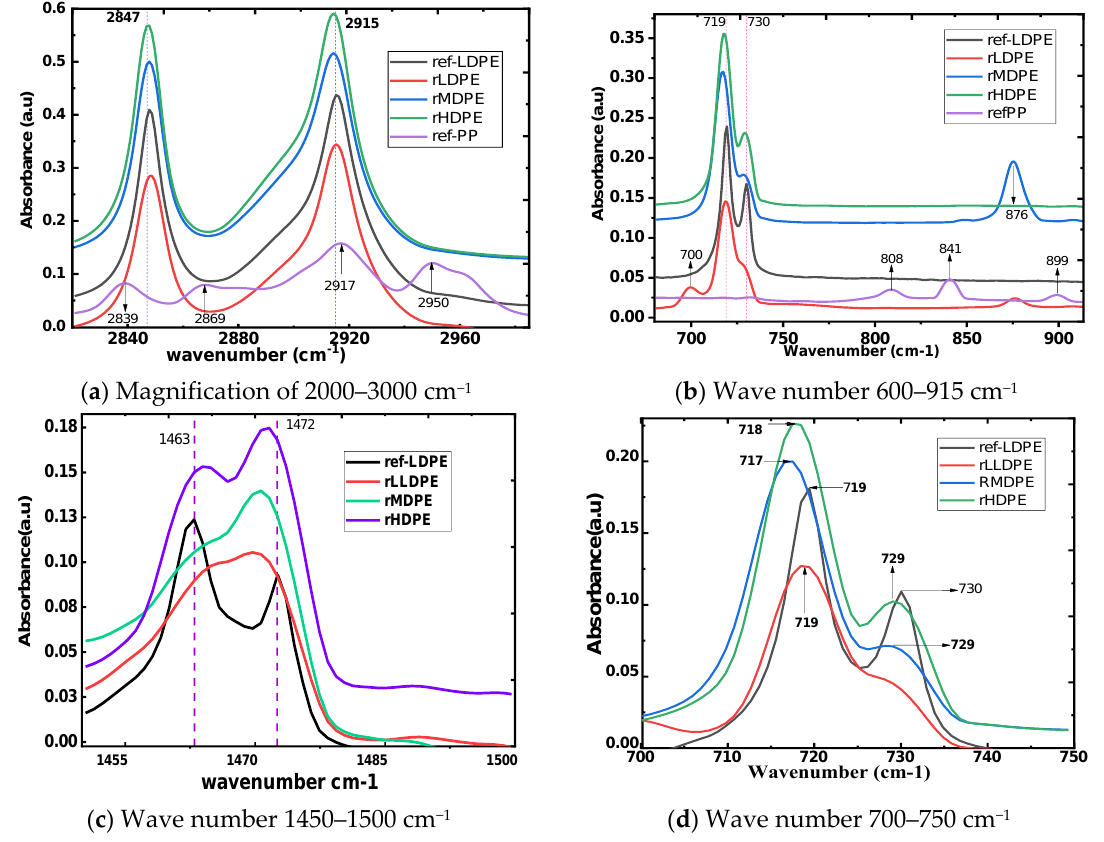
Figure 5. FTIR characterization of post-consumer PE types (LLDPE, MDPE, and HDPE). The unusual band region of rHDPE at 880 cm −1 is C-H out of plane bending vibrations for aromatics 1,3-disubstitution which could be related to the residual aromatic bearing of colorant molecules in the prehistory of rHDPE material. The difference in spectrum splitting compared with ref-LDPE could have resulted from repetitive thermal processing that leads to decreased linear character of the polymeric chains and decreased crystallinity. Table 3. Main absorptions of PE in the IR region and their assignment. Reprinted/adapted with permission from Ref. [47] © 2006, John Wiley and Sons and Ref.[53] © 2002, Elsevier